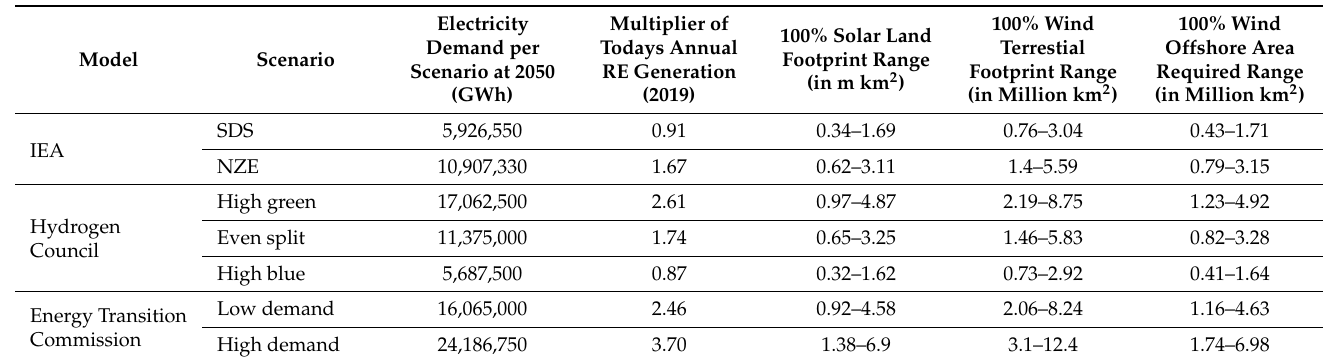
Table 4. Electricity demand and associated land footprints from green hydrogen demand per model- scenario.